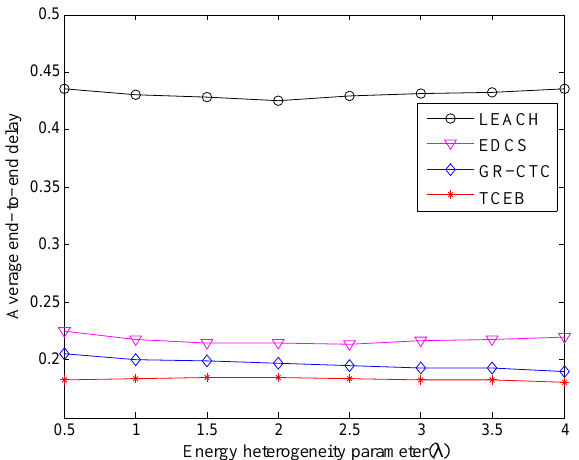
Figure 11. The comparison of average end-to-end delay under different energy heterogeneity factor ( n = 100 )